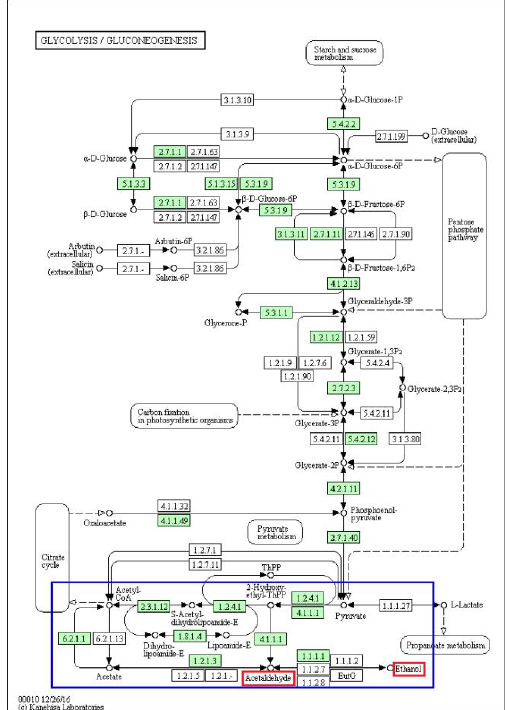
Figure 3. Pathway of the biosynthesis of ethanol. The red and green boxes indicate the substrates and existing homologous genes of the enzyme, respectively; The white boxes mean the enzymes that were not identified in A.heimuer genome. The blue box indicates the core region of the function. The figure was generated by a KEGG mapper.